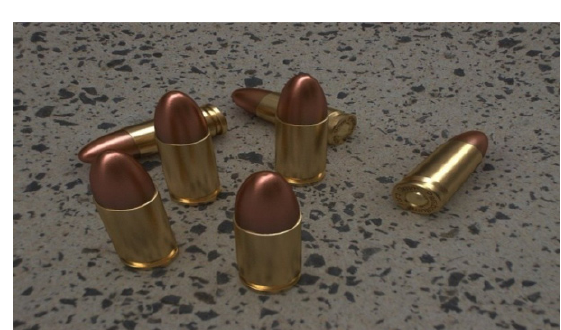
Figure 1. Stress-Strain diagram of Kevlar/Epoxy specimen(0/90).